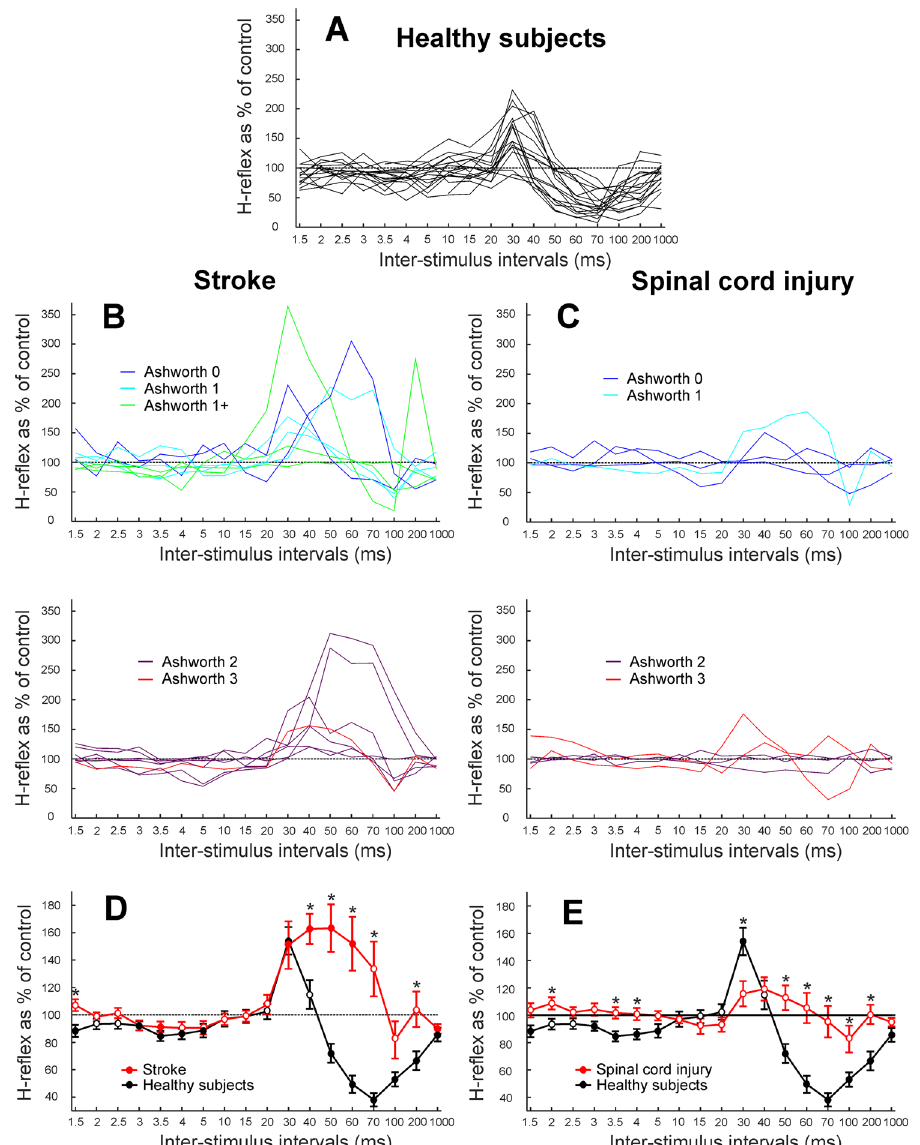
Figure 2. Measurement of H-reflex amplitude when conditioned by ECR muscle stimulation, as a percentage of the unconditioned reflex. Values are plotted against the inter-stimulus interval. ( A) Overlain individual results from 17 healthy volunteers. ( B ) Overlain results from 15 patients with stroke. ( C ) Overlain results from 9 patients with spinal cord injury. In ( B , C ) plots have been separated according to the level of spasticity, determined by the Ashworth scale. ( D ) Average data from all individuals with stroke (red). ( E ) Average data from all individuals with spinal cord injury (red). In ( D , E ) the average from healthy subjects (black) is shown for comparison. Filled circles represent responses significantly different from unconditioned reflex (paired t-test, p < 0.05) and error bars represent standard error. Asterisks mark intervals with significant differences between the patient group and healthy controls (p < 0.05,